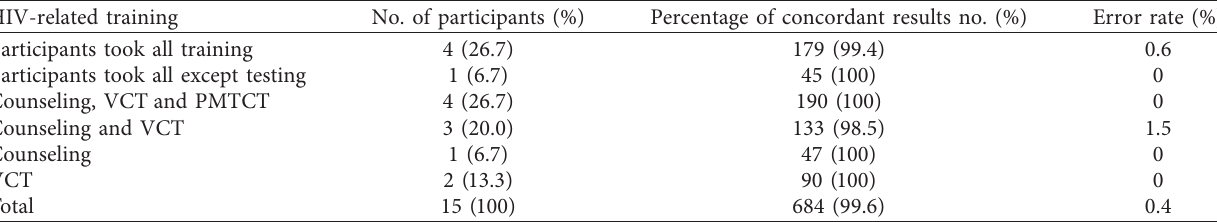
Table 1: Proportions of health extension workers who have taken HIV-related training before and percentage of their performance.